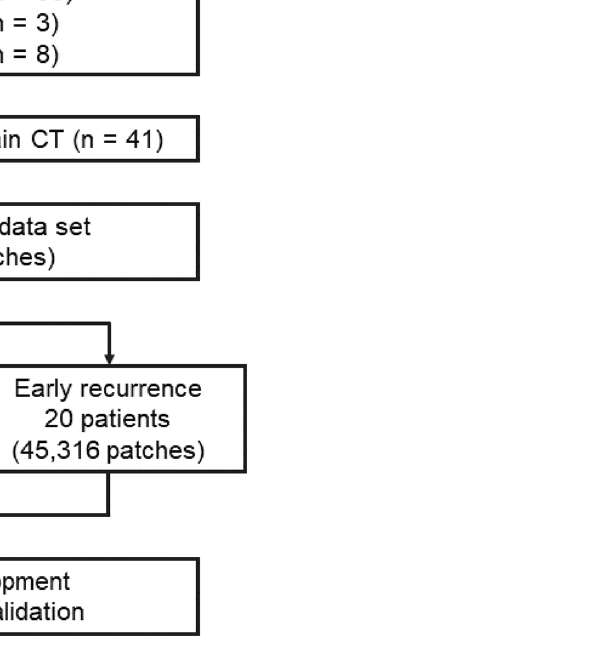
Figure 1. The study workflow and methodological